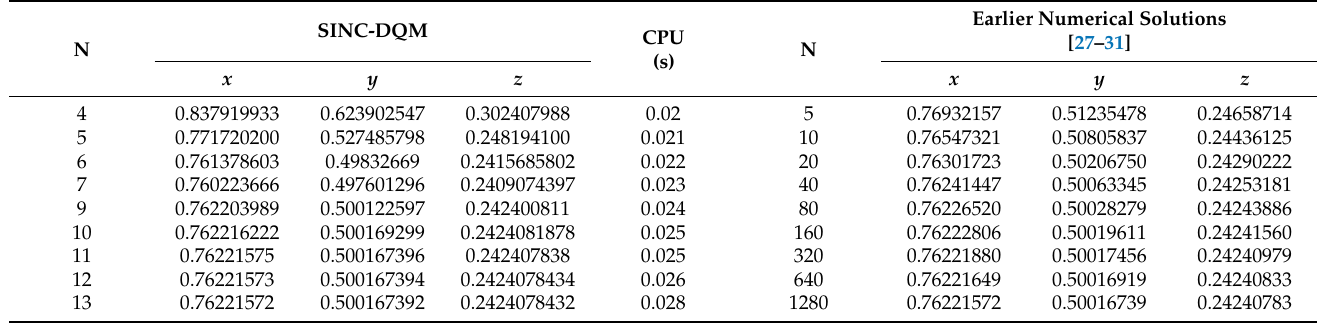
Table 2. Computation of x , y , and z via SINC-DQM for fractional Chen system (Lorenz system) with time ( T = 5 ) and fraction powers λ = 1.2, γ = 0.85 at various grid points ( N ) . a